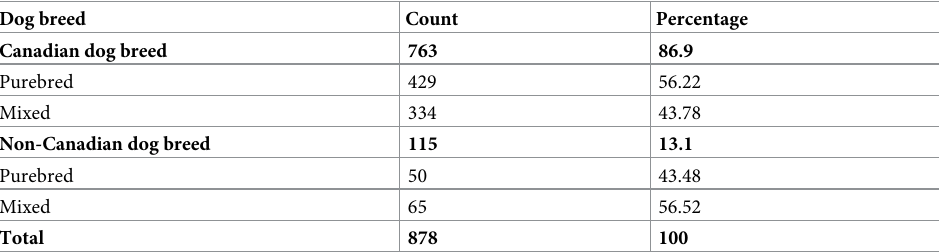
were small dogs (43.4%, n = 50) (Table 15). Over half of non-Canadian dogs were mixed breed (Table 16). Toy breeds were the most common breed type of non-Canadian purebred dogs (34%, n = 17; S2 File). Non-Canadian dogs were mostly acquired either as a puppy (33%, n = 38) or as an adult (33%, n = 38) (Table 17). Surprisingly, there were 16 non-Canadian dogs that were acquired as a “Newborn” ( < 8 weeks) (13.9%, n = 16; S2 File). The majority of non- Canadian dogs were acquired through a rescue organization or a shelter (Table 18). Logistic regression. Female owners, dogs acquired as an adolescent or as an adult, and large dogs yielded a statistically significant value in predicting the outcome of dog origin (Table 19). Female owners were at 1.6 odds (CI 95%: 1.054–2.602) more likely of acquiring non-Canadian dogs compared to male owners (Fig 4). Canadian dog owners were 58.1% women compared to 69.8% of non-Canadian dog owners who were women. Dogs acquired as an adolescent or as an adult were also 2.1 odds (CI95%: 1.003–4.47) and 1.9 odds (CI95%: 1.034–3.87) more likely of originating outside of Canada compared to dogs acquired as a new- born respectively. Dogs acquired as an adolescent made up 7.9% of Canadian dogs, compared to 17% of non-Canadian dogs that were acquired as an adolescent. Dogs acquired as an adult made up 17.4% of Canadian dogs compared to 33.6% of non-Canadian dogs. Large dog breeds were 0.5 odds (CI95%: .294—.865) less likely than small dog breeds to be of non-Canadian ori- gin. Canadian dogs were comprised of 31.1% large dogs compared to 20.7% of non-Canadian dogs.